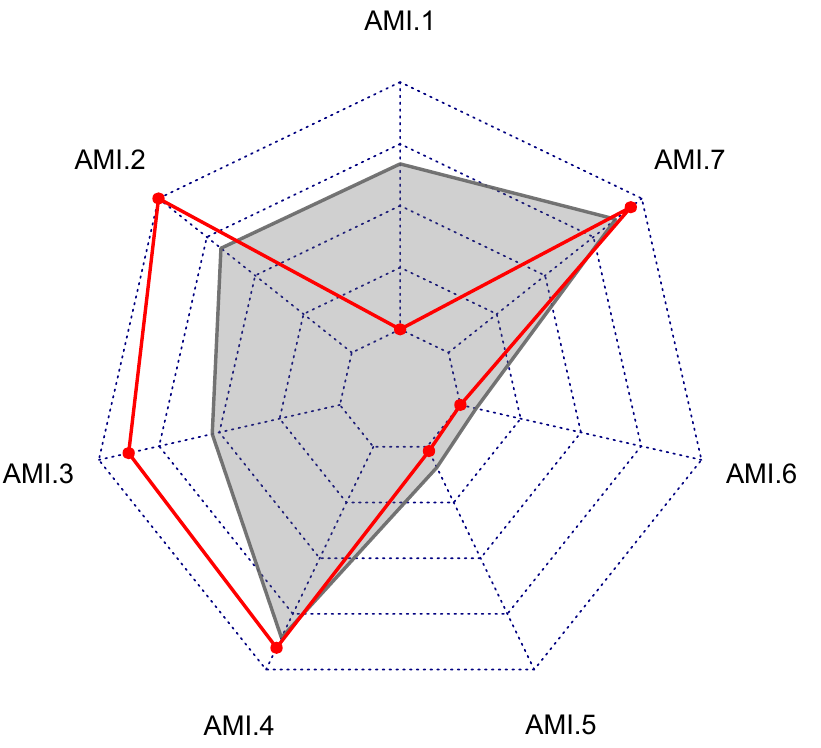
Figure 9. An example of a radial plot showing average values of indicators for AMI as the outer contour of the gray area, and values for a chosen hospital as a red contour. Values of each indicator range from the worst value in the center, to the best value at the